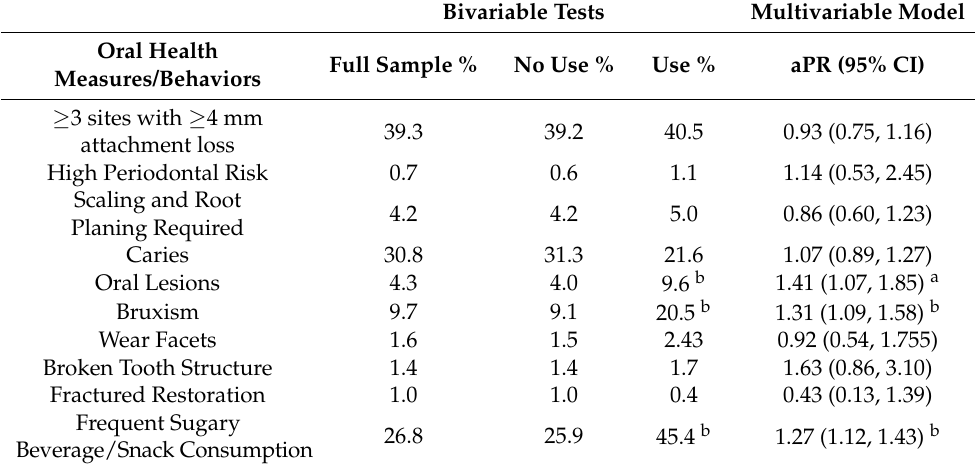
Table 2. Associations between self-reported lifetime cannabis use and oral health outcomes.